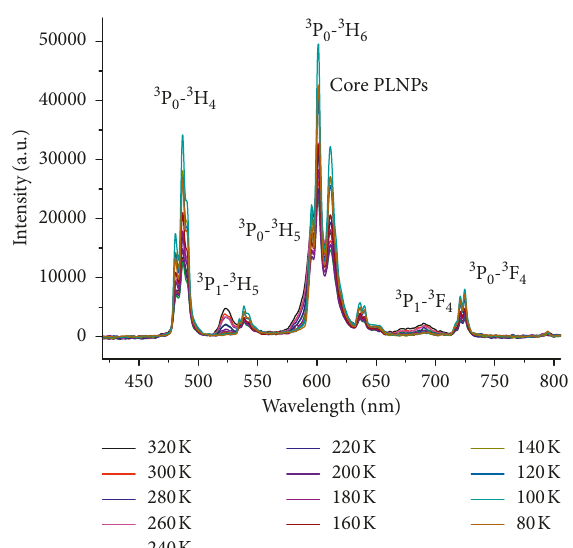
Figure 7: Luminescence spectra of the core nanospheres Pr 3+ :LaF 3 as a function of temperature obtained under laser excitation at 444nm ± .